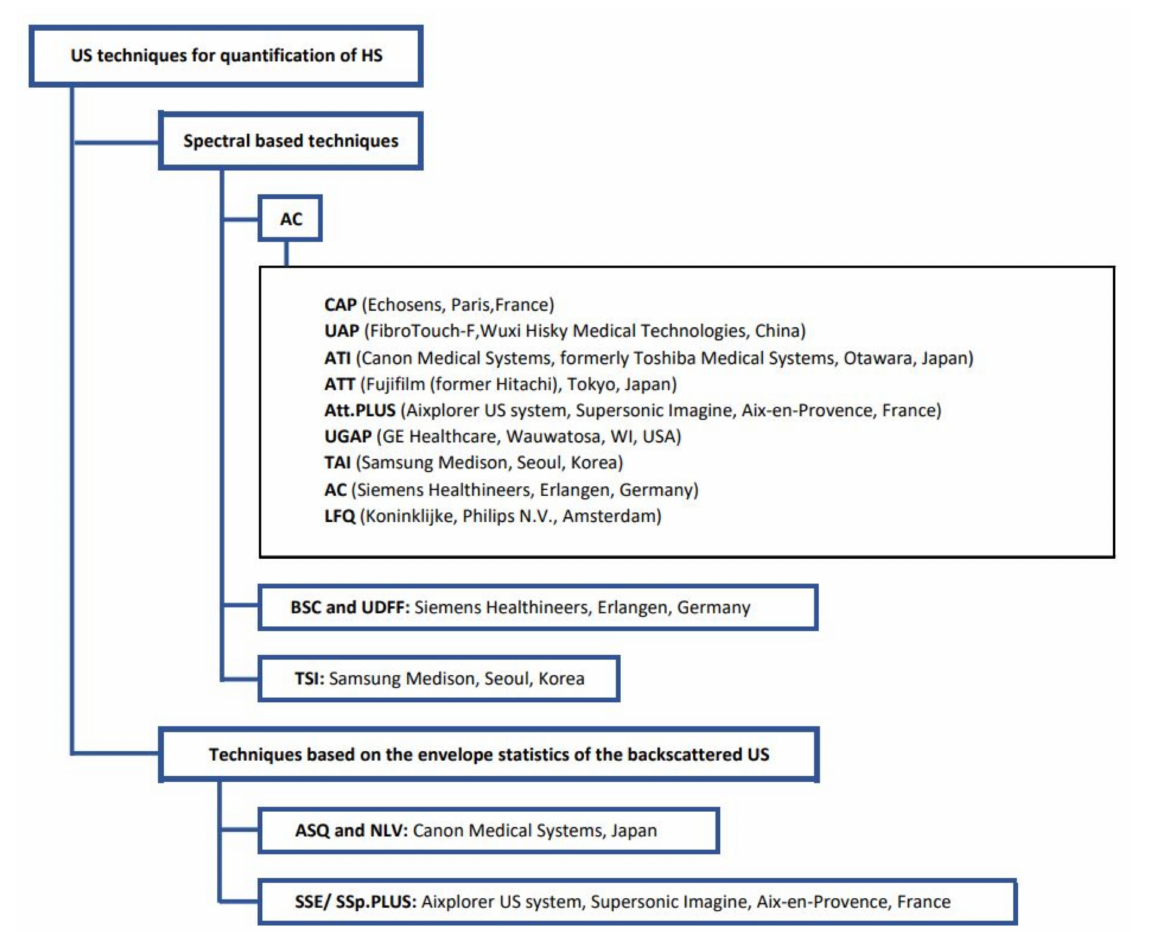
Scheme 2. Classification of the ultrasound-based techniques used for the quantification of liver steato- sis. HS: hepatic steatosis; AC: attenuation coefficient; CAP: controlled attenuation parameter; UAP: ultrasound attenuation parameter; ATI: attenuation imaging; ATT: attenuation measurement function; Att.PLUS: attenuation plane-wave ultrasound; UGAP: ultrasound-guided attenuation parameter; TAI: tissue attenuation imaging; BSC: backscatter coefficient; UDFF: ultrasound-derived fat fraction; TSI: tissue scatter distribution imaging; NLV: normalized local variance; ASQ: acoustic structure quantification; SSE: speed of sound estimation; SSp.PLUS: sound speed plane-wave